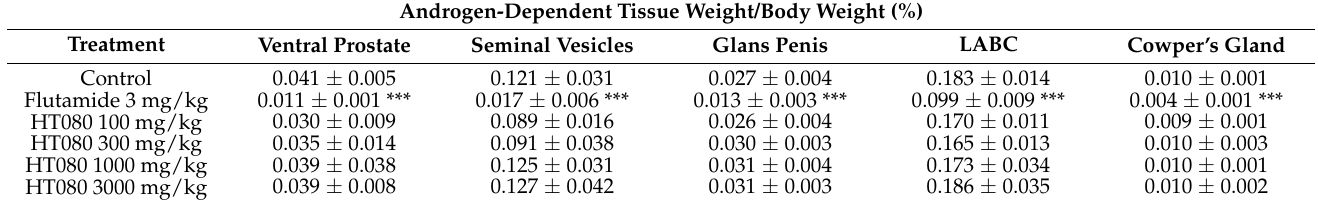
Table 1. Effects of orally administered flutamide and HT080 on androgen-dependent tissue weights of testosterone propionate-supplemented castrated